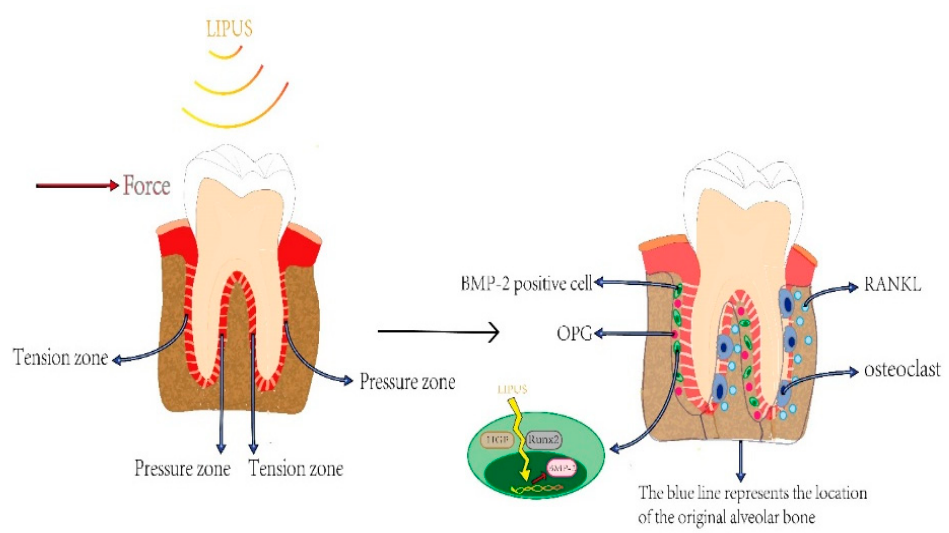
Figure 4. LIPUS has an effect on both the tension zone and the pressure zone in the OTM process. During OTM, the tension zone happens to bone remodeling while the pressure zone occurs bone resorption. LIPUS is able to stimulate the expressions of osteoclasts and RANKL in the pressure zone and promote the production of OPG and BMP-2 through the HGF/Runx2/BMP-2 pathway in the tension zone, thereby expediting OTM.